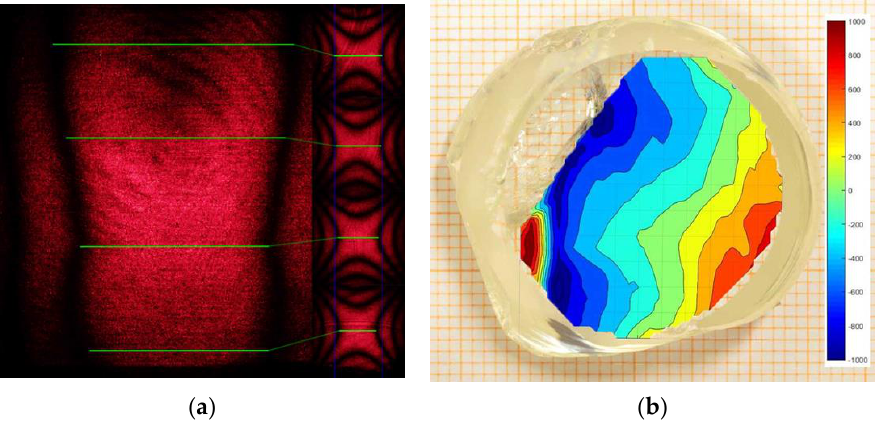
Figure 6. ( a ) PWO sphenoscopic image. The inset on the right side shows the conoscopic images carried out over four points, while the larger image represents the sphenoscopic fringe pattern obtained in the same area by a single acquisition [14]. ( b ) The map of stress distribution superimposed to the sample surface, which is in line with the presence of defects in the PWO crystal [14] (used with permission from IOP; [14]).